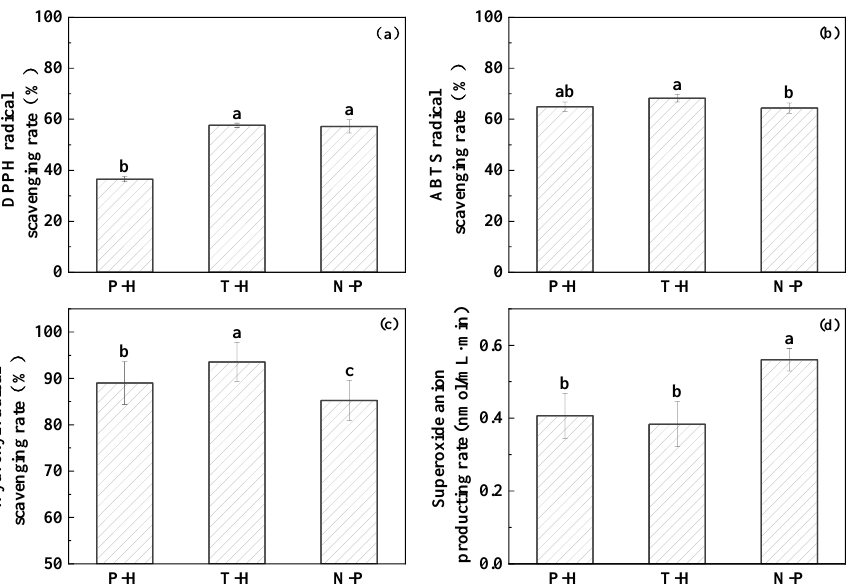
Figure 2. ( a ) DPPH radical scavenging rate, ( b ) ABTS radical scavenging rate, ( c ) hydroxyl radical scavenging rate, and ( d ) superoxide anion production rate of the three peptides. Note: In the significance analysis, the letters from a to c represent the values from large to small, and different letters represent significant differences ( p < 0.05).